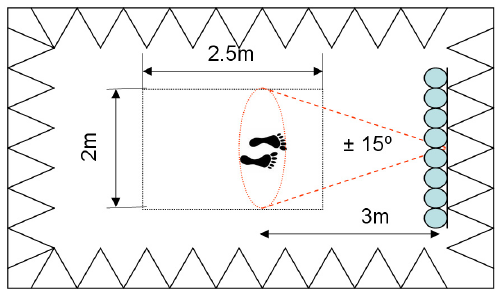
Figure 14. Scanning and positioning area.